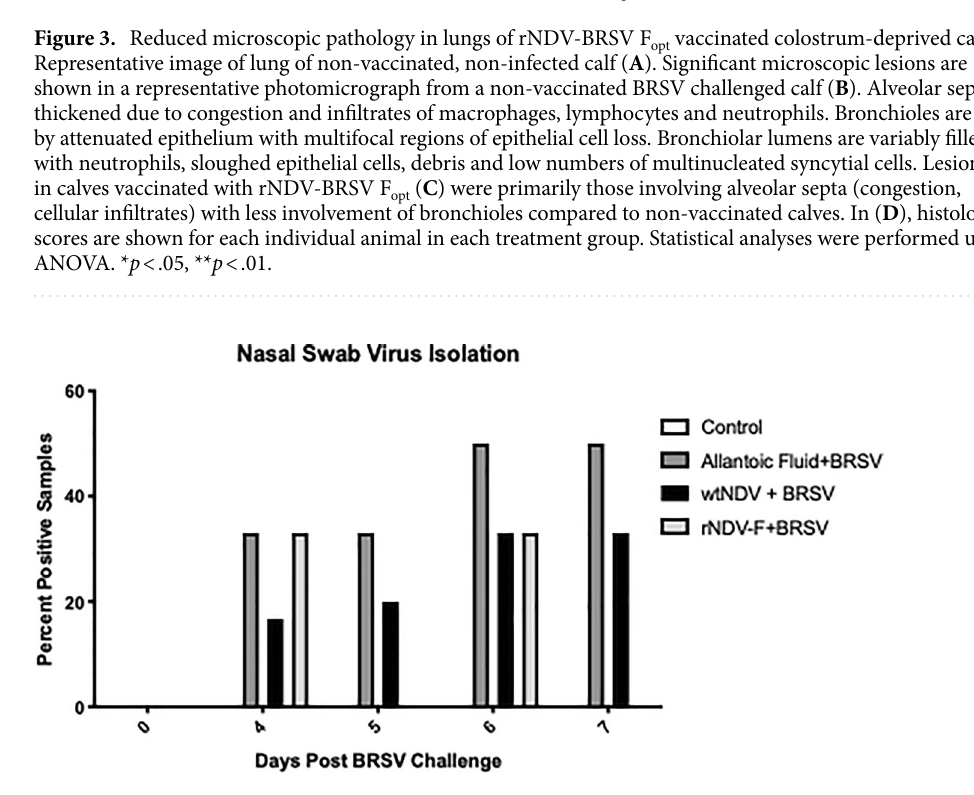
and 3/6 BRSV rNDV-BRSV F opt vaccinated calves. Taken together, results of nasal swab virus isolation indicate reduced duration of BRSV shedding in BRSV rNDV-BRSV F opt vaccinated calves compared to calves receiving an intranasal inoculation of allantoic fluid. Reduced viral burden in lungs of BRSV rNDV‑BRSV F vaccinated calves. Lung tissue samples opt were collected from representative gross lesions at necropsy on day 7 for virus isolation. Homogenates of lung